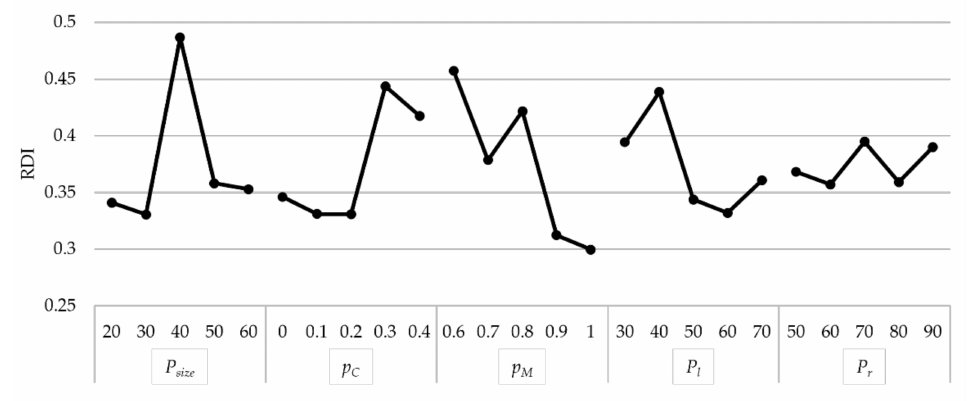
Figure 8. GA calibration for P size , p C , p M , P l , and P r